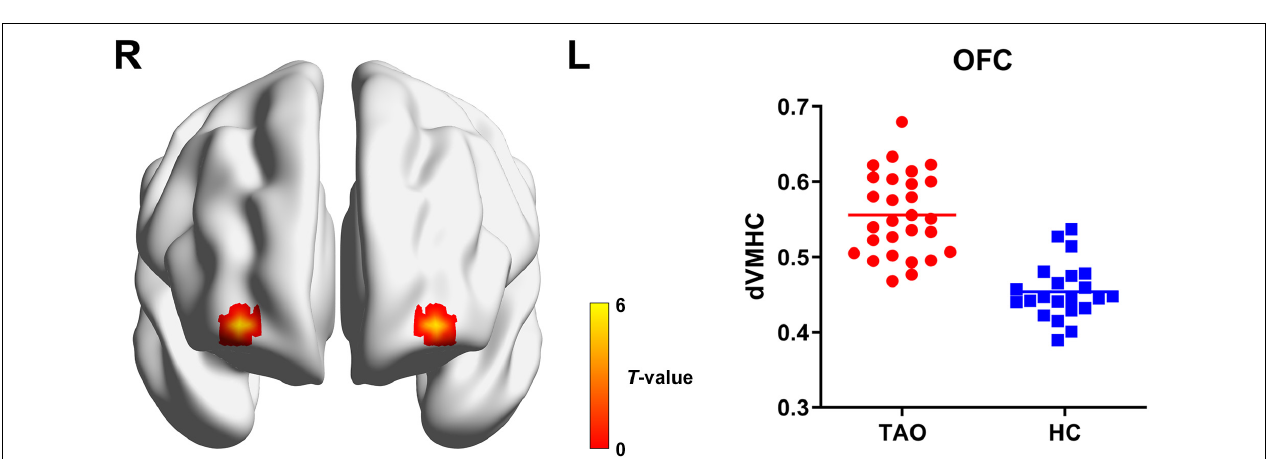
FIGURE 2 | Brain regions with significant dynamic VMHC difference between TAO group and HCs. Compared with HCs, TAO group showed significantly increased dynamic VMHC variability in OFC ( P < 0.05, cluster-level FWE corrected). The warm color denotes relatively higher values in TAO group, and the color bar indicates the t -value from two-sample t -test between TAO group and HCs. VMHC, voxel-mirrored homotopic connectivity; TAO, thyroid-associated ophthalmopathy; HCs, healthy controls; OFC, orbitofrontal cortex; FWE, family-wise error; R, right; L, left; dVMHC, dynamic